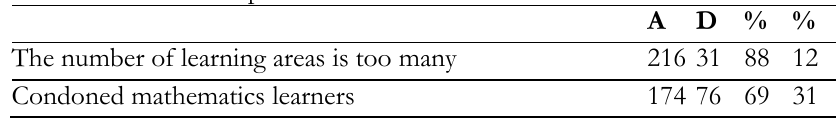
Table 2. Educational